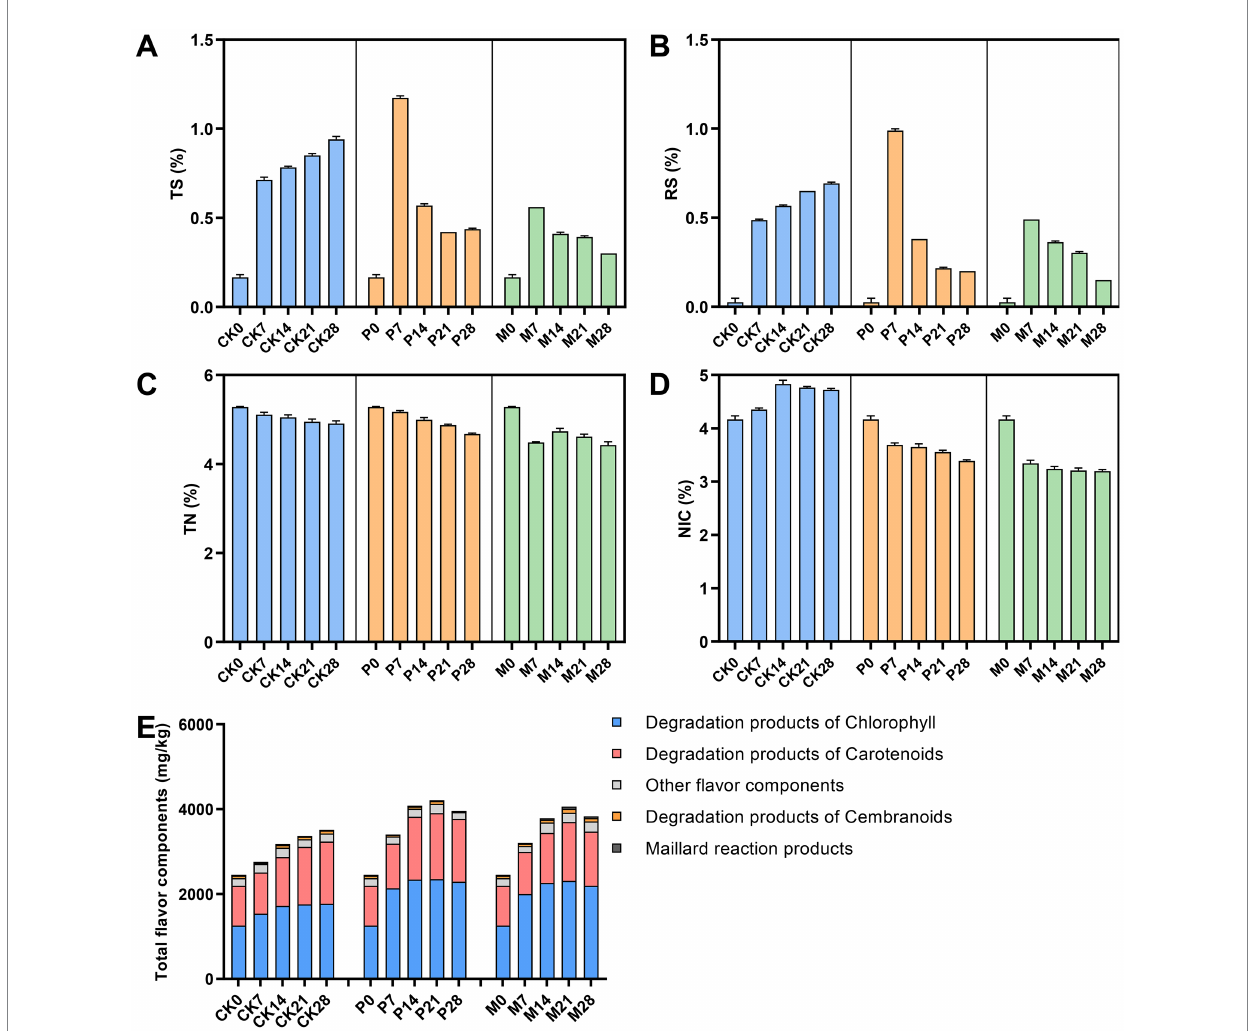
FIGURE 4 Changes of physicochemical metabolite during bioaugmentation fermentation by different Candida strains. (A) Total sugars content; (B) Reducing sugar content; (C) Total nitrogen content; (D) Total alkaloids content; (E) Total flavor components content. TS, total sugar; RS, reducing sugar; TN, total nitrogen; NIC, alkaloid. CK0-CK28: Control group; P0-P28: C. parapsilosis group; M0-M28: C. metapsilosis group, and the numbers 0, 7, 14, 21, 28 indicated the fermentation